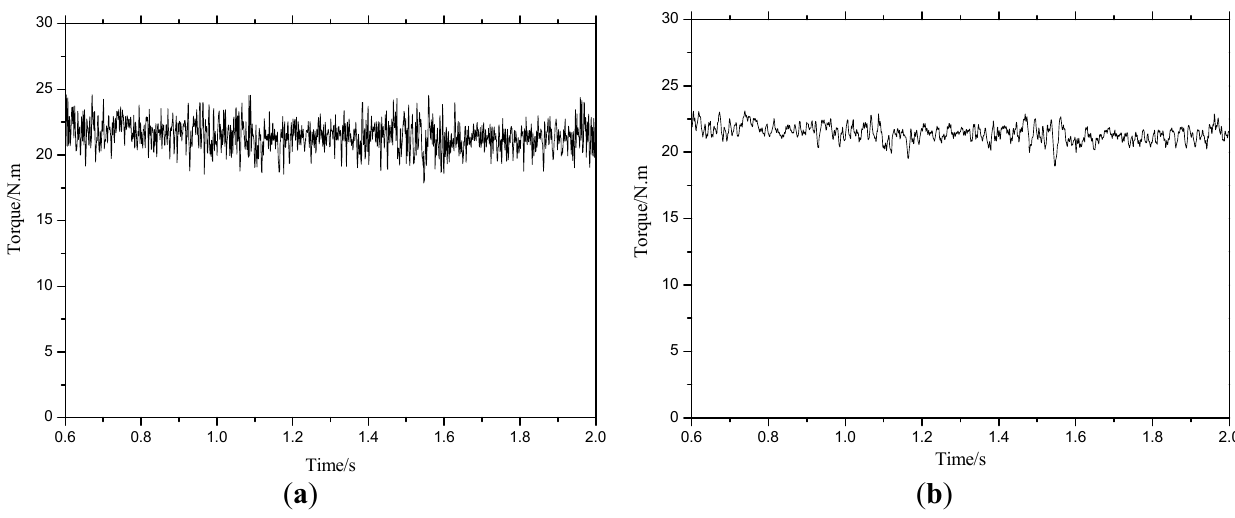
Figure 10. Time response of the output torque in steady state when using different = 20 N. m and n = 1000 rpm: ( a ) conventional PI controller; and ( b ) controller when T L proposed sliding mode